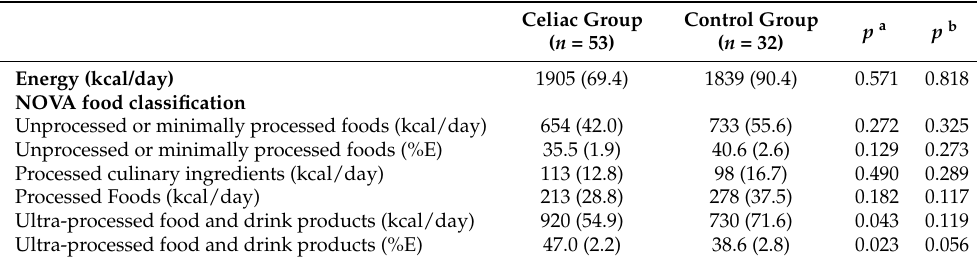
Table 2. Differences in food groups consumption and NOVA food classification of children by celiac disease (celiac vs. control